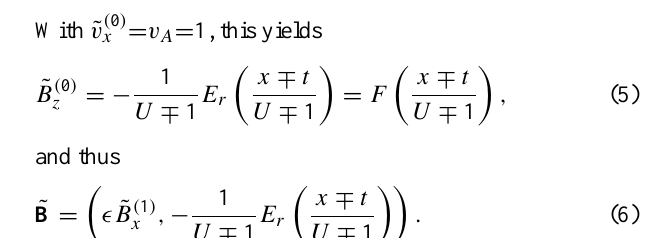
Fig. 6. Growth of the shock structure. The upper and lower panels show the growth during switch-on and switch-off phase, respec- tively.